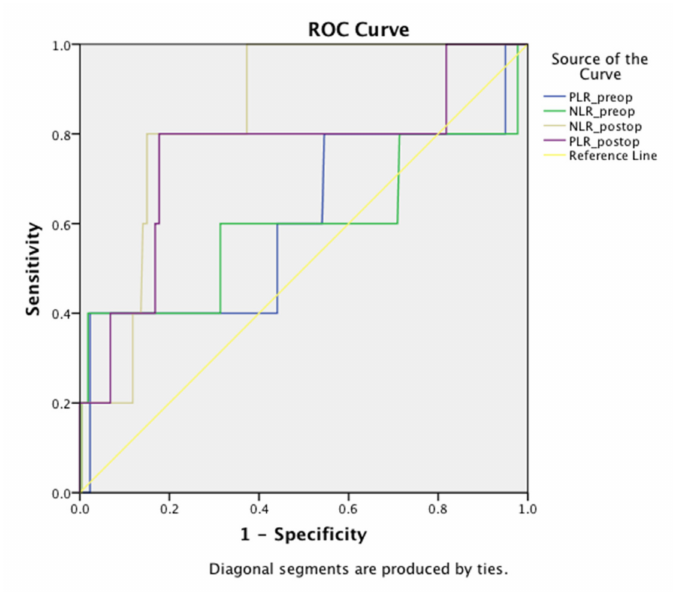
Figure 1. Receiver operating characteristic curve for NLR and PLR with respect to AKI. NLR: neutrophil–lymphocyte ratio; PLR: platelet–lymphocyte ratio; Preop: preoperative; Postop: postoper- ative; AKI: acute kidney injury; ROC: receiver operating